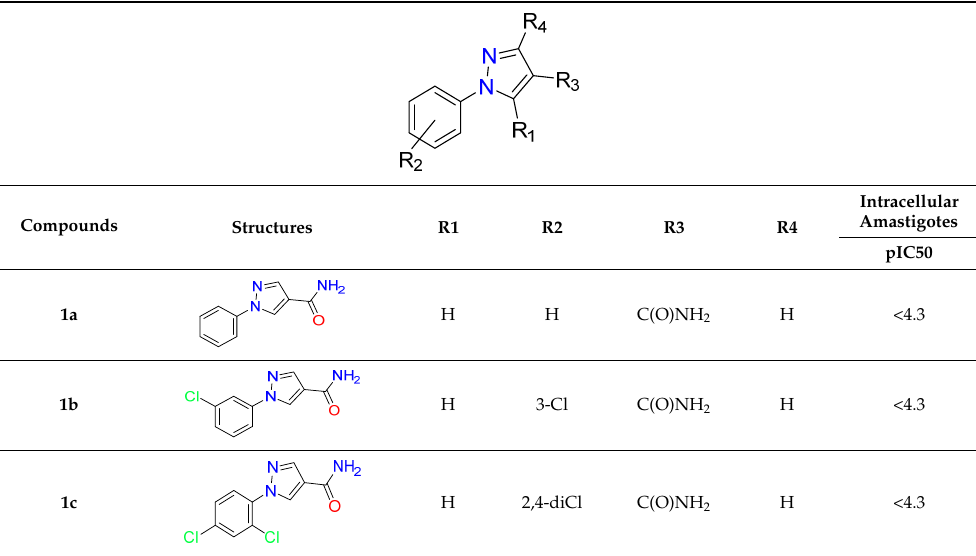
Table 2. Structure-activity relationship (SAR) analysis of pyrazole derivatives (pyrazole-carboxamide Table 2. Structure ‐ activity relationship (SAR) analysis of pyrazole derivatives (pyrazole ‐ and pyrazole-imidazoline series). carboxamide and pyrazole ‐ imidazoline series). Table 2. Structure ‐ activity relationship (SAR) analysis of pyrazole derivatives (pyrazole ‐ Table 2. Structure ‐ activity relationship (SAR) analysis of pyrazole derivatives (pyrazole ‐ Table 2. Structure ‐ activity relationship (SAR) analysis of pyrazole derivatives (pyrazole ‐ carboxamide and pyrazole ‐ imidazoline series). carboxamide and pyrazole ‐ imidazoline series). carboxamide and pyrazole ‐ imidazoline series).